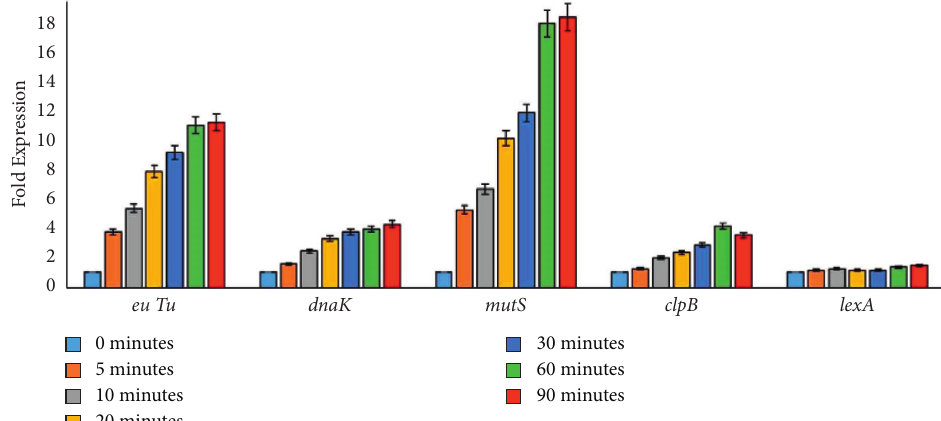
Figure 3: Transcriptomic profiling of Klebsiella pneumoniae clinical isolates under ciprofloxacin stress. The graph indicates a change in ftsZ expression in a time-dependent manner. The X -axis represents time, whereas the Y -axis displays the fold